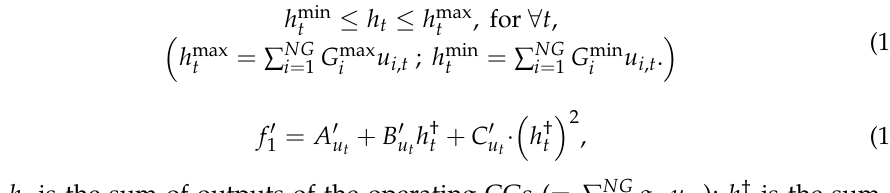
Table 1. Specifications of CGs (“¥” means “any currency unit is applicable”).